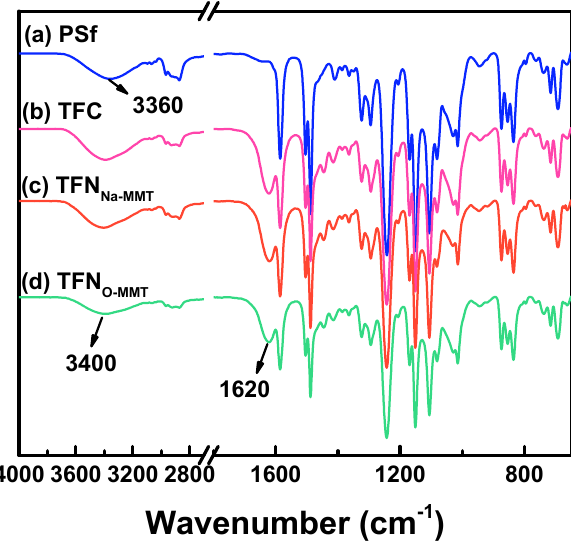
Figure 4. ATR-FTIR spectra of polysulfone (PSf), thin-film composite (TFC) and thin-film nanocomposite (TFN) membranes. Particle concentration = 0.05 g O-MMT/ g TMC.